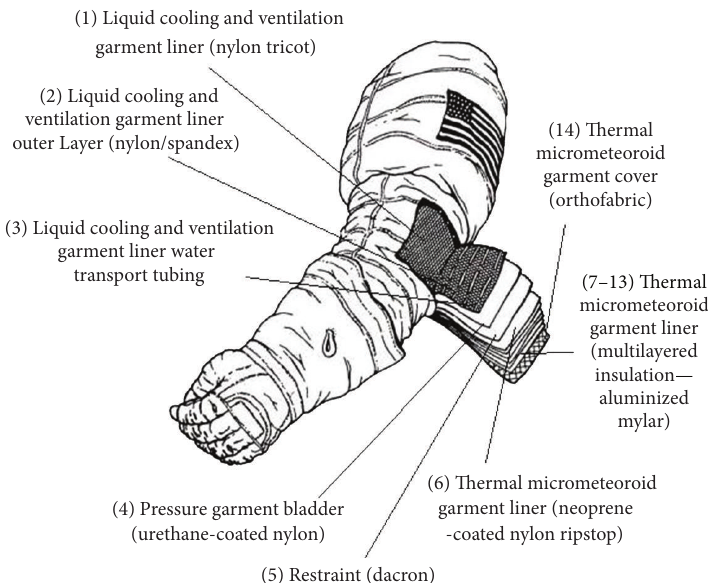
Figure 6: Layers in an extravehicular mobility unit (Image courtesy